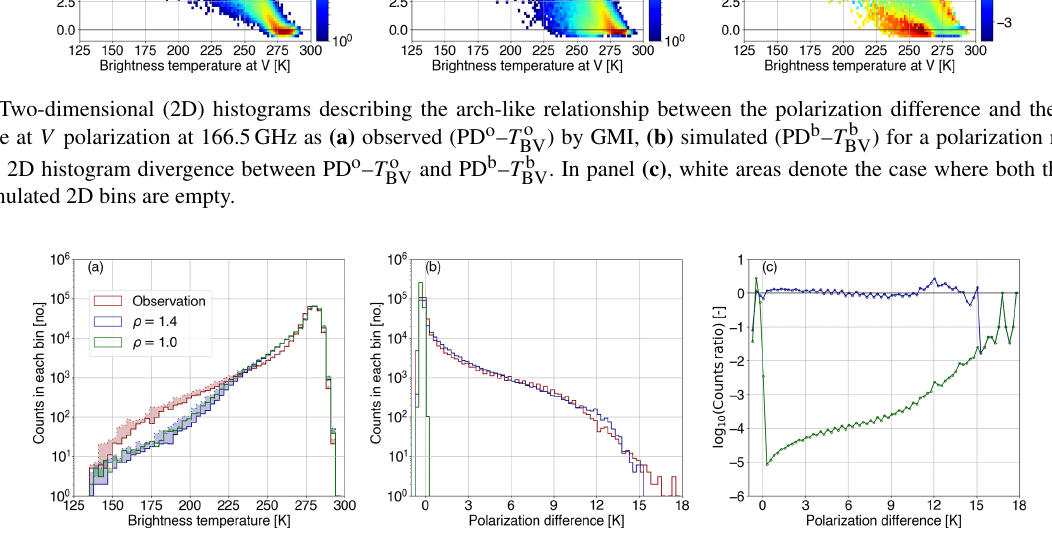
; red) by GMI and simulated ( T b ) for a polarization ratio B B